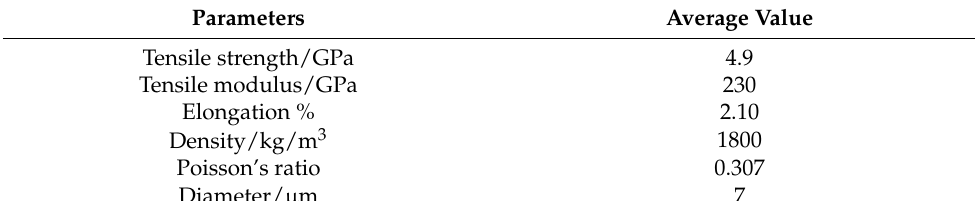
Table 1. Mechanical parameters of the T700SC-12000-50C carbon fiber bundle [56].